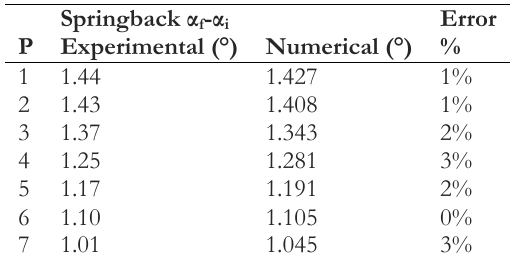
Table 5. Error for thickness 1.5 mm.